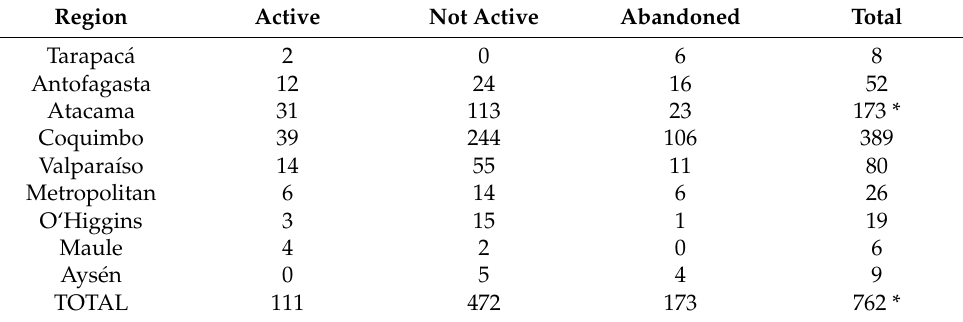
Table 1. Regional distribution and state of tailings deposits (2021).